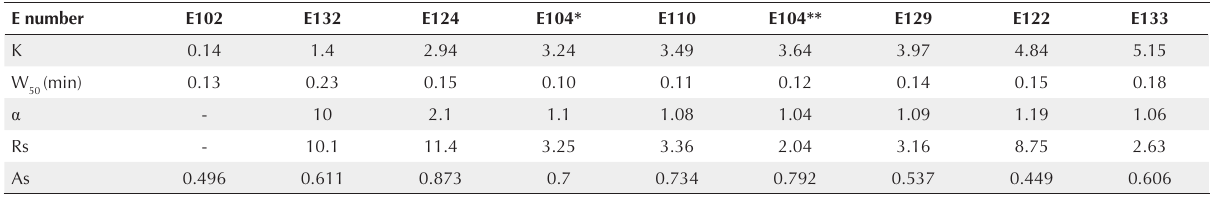
Table 2. Chromatographic Parameters (based on Figure 2) for Individual Peaks (k: capacity factor, W Peak, Rs: Resolution to Proceeding Peak Calculated by Half Width Method, As: Symmetry Factor)